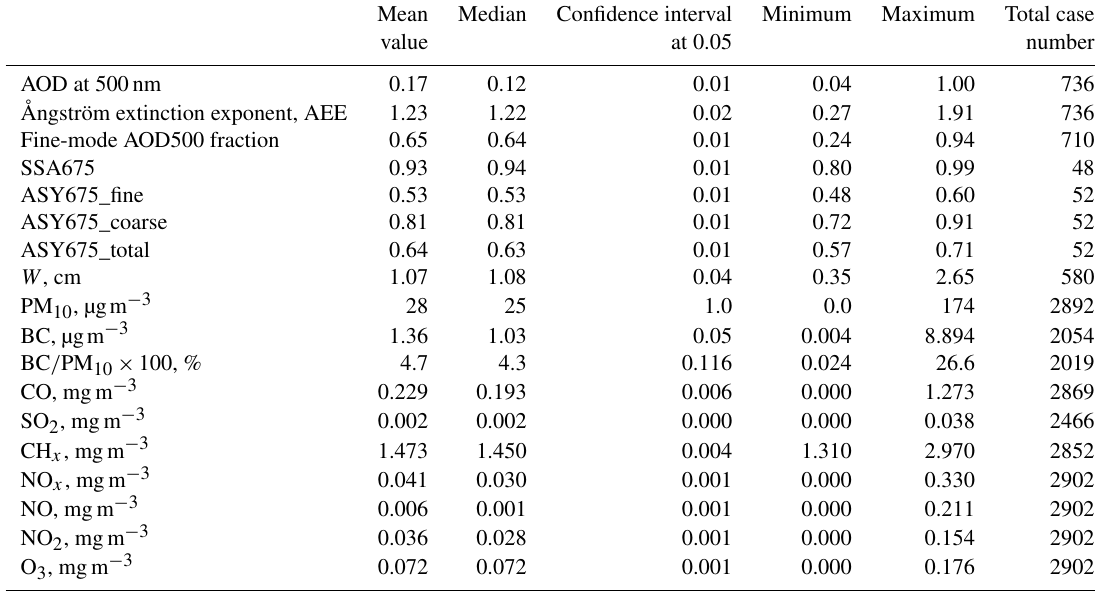
Table 1. Statistics of hourly mean aerosol characteristics in the total column of the atmosphere and at the surface, including aerosol optical depth (AOD at 500nm), Ångström extinction exponent, fine-mode fraction at 500nm, single-scattering albedo (SSA) at 675nm, factor of asymmetry (ASY) for fine, coarse and total aerosol at 675nm, water vapor content ( W , cm) and surface mass concentrations of PM 10 ,